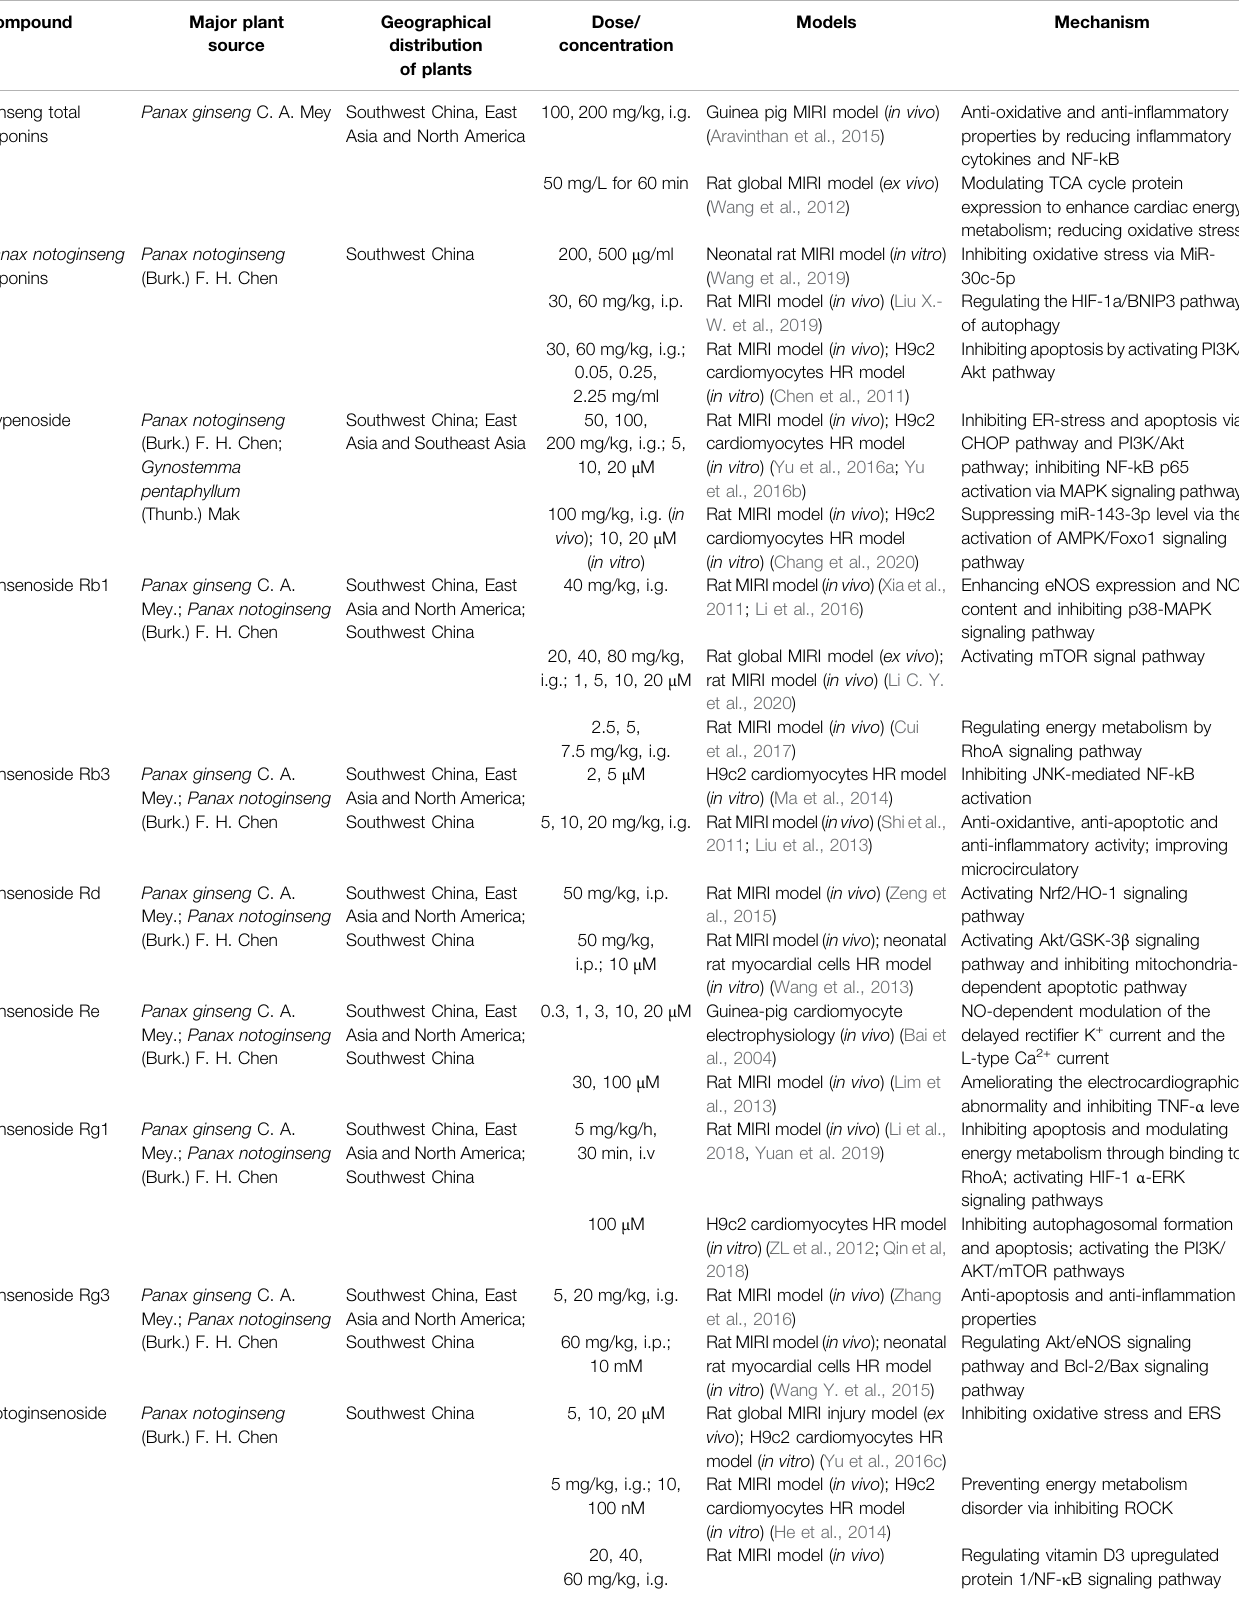
TABLE 1 | Anti-MIRI effects of saponins from ginseng .